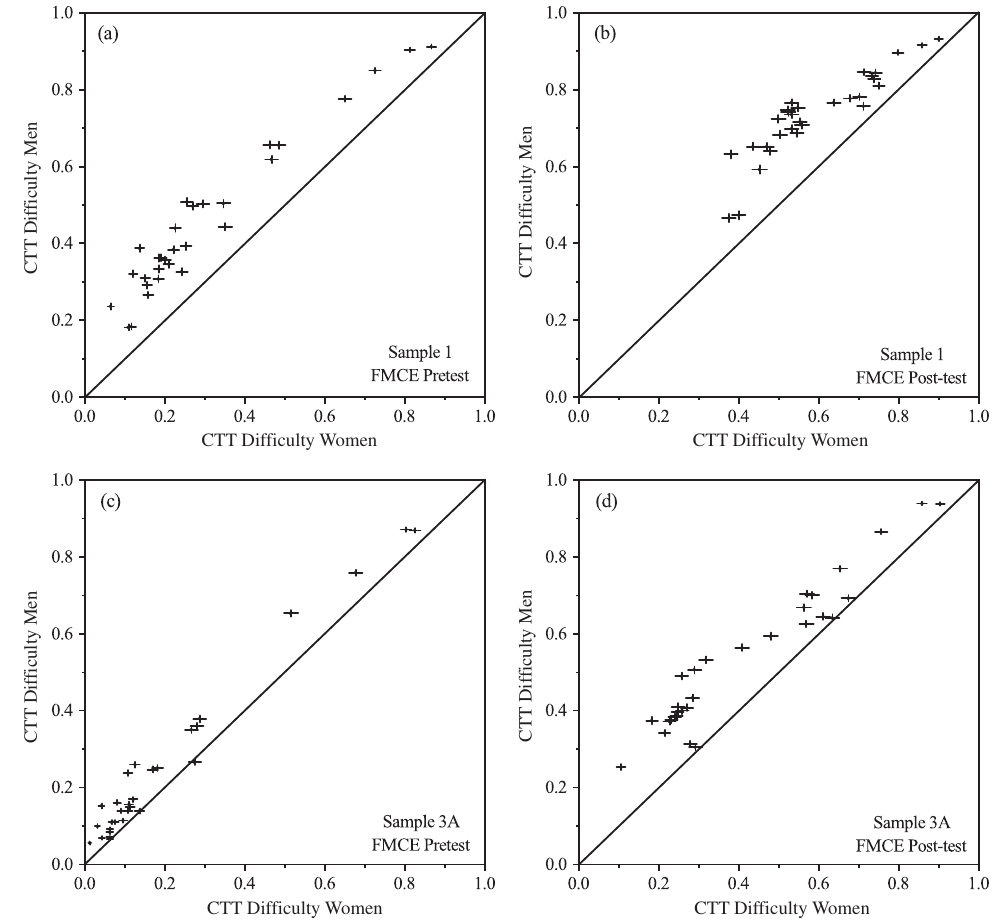
FIG. 1. CTT difficulty results for the FMCE. The top two panels are sample 1 (a) FMCE pretest and (b) FMCE post-test. The bottom two panels are sample 3A (c) FMCE pretest and (d) FMCE post-test. A line of slope 1 is drawn to allow comparison of male and female difficulty. Error bars represent 1 standard deviation in each